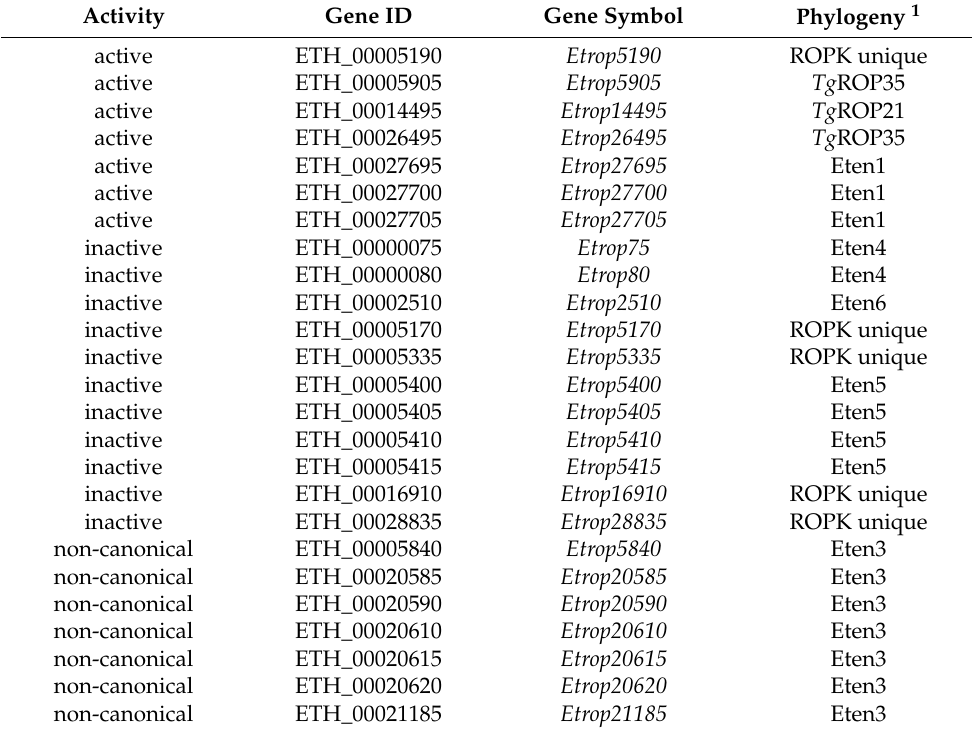
Table 1. Rhoptry kinase genes from the Eimeria tenella